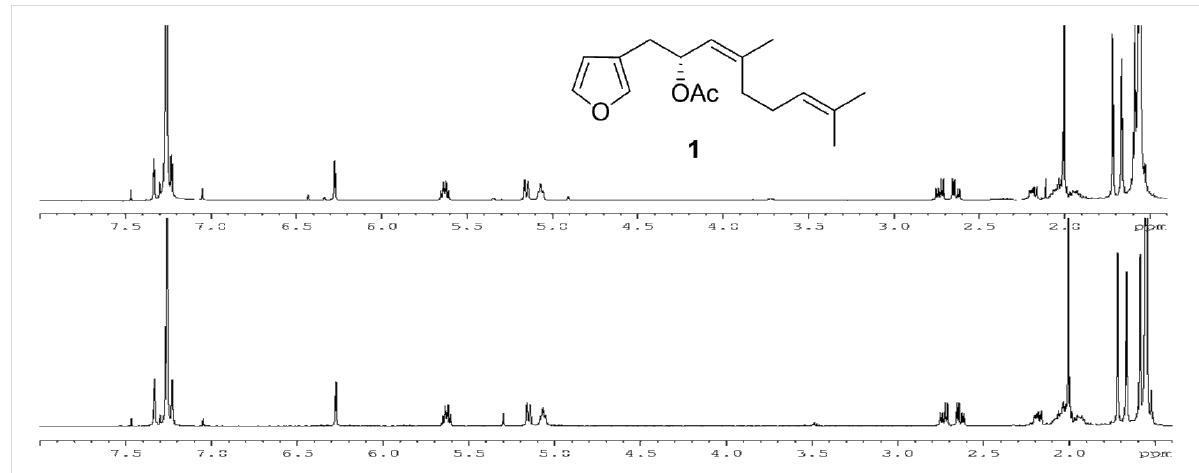
Figure 5: The 1 H NMR (CDCl 3 , 500 MHz) spectroscopic comparison of (6 Z )-dendrolasin-5-acetate ( 1 ): (a) sample isolated from H. jacksoni ; (b) syn- thetic sample of ( − )-(6 Z )- 1 .